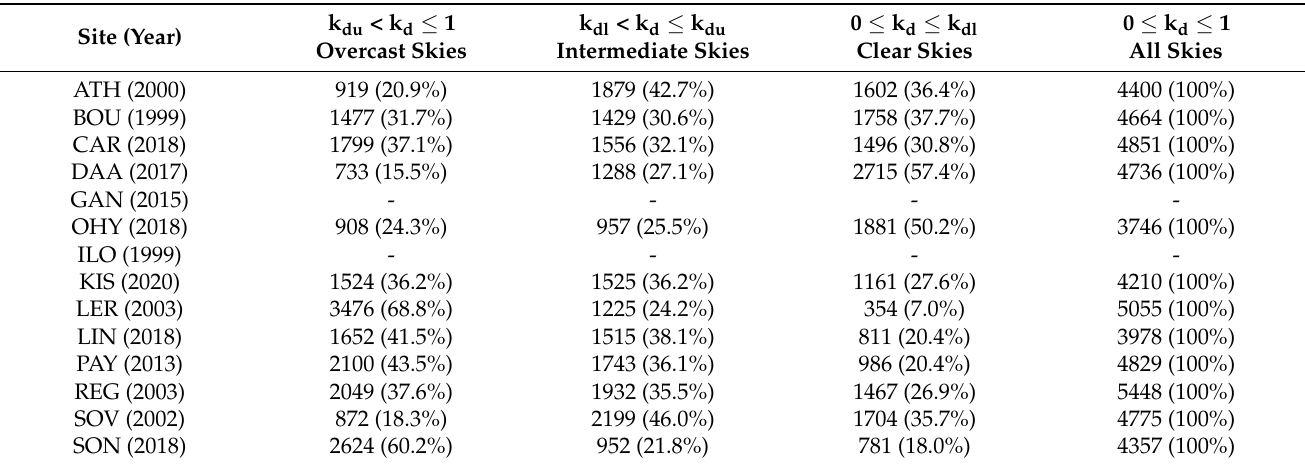
Table 3. Number of (daytime) hourly SSD values at each site within the year indicated for the various k d conditions; percentages of the individual cases to the total are given in